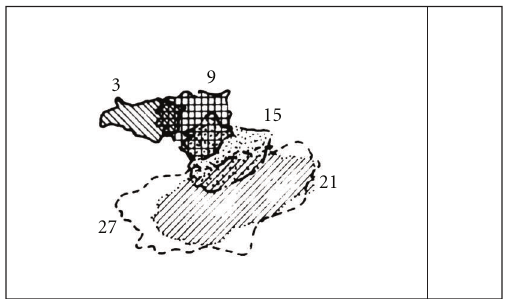
Figure 10: Development of 6 μ m oil thickness contours in experi- mental